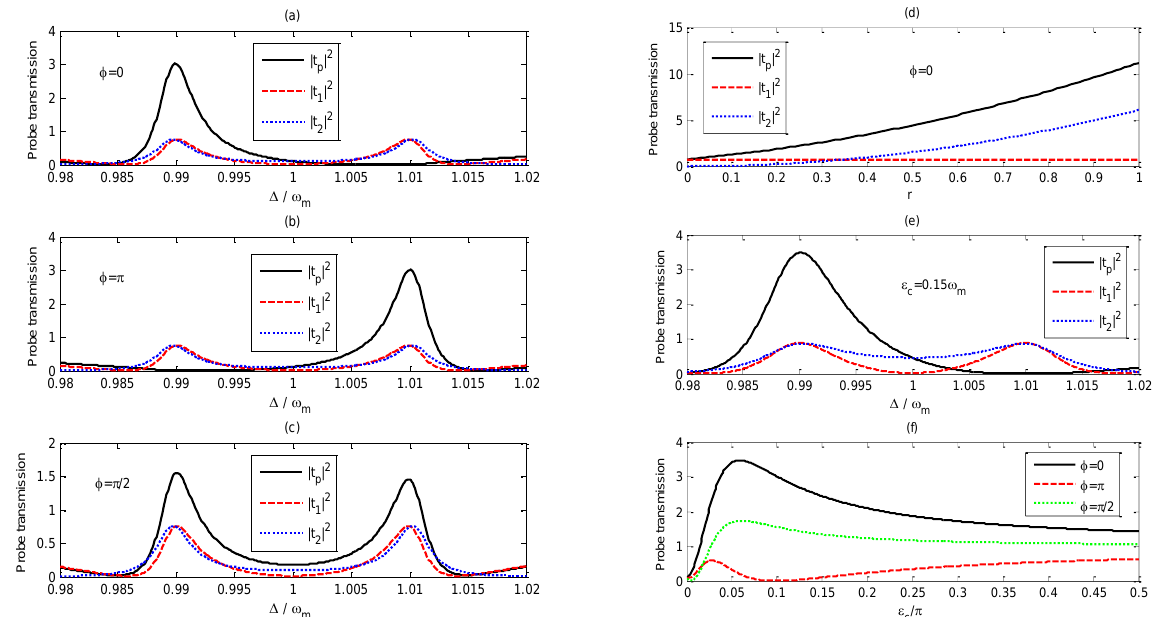
Figure 3. Curves of |𝑡 𝑝 | 2 , |𝑡 1 | 2 , |𝑡 2 | 2 vary with the probe-pump field detuning 𝛥 𝜔 𝑚 ⁄ when 𝜙 equals to ( a ) 0, ( b ) 𝜋 and ( c ) 𝜋 2⁄ , respectively. ( d ) Curves of |𝑡 𝑝 | 2 , |𝑡 1 | 2 , |𝑡 2 | 2 at ∆ = 𝜔 𝑚 − 𝐽 vary with 𝑟 = 𝜇𝜀 𝑞 𝜀 𝑝 ⁄ when the phase difference 𝜙 = 0 . ( e ) Curves of |𝑡 𝑝 | 2 , |𝑡 1 | 2 , |𝑡 2 | 2 vary with the probe-pump field detuning 𝛥 𝜔 𝑚 ⁄ for 𝜙 = 0 when the pump field am- plitude 𝜀 c equals to 0.15𝜔 𝑚 and 𝑟 = 0.52 . ( f ) Curves of |𝑡 𝑝 | 2 at ∆ = 𝜔 𝑚 − 𝐽 vary with pump field amplitude 𝜀 𝑐 2𝜋⁄ for different phase difference ϕ when r =0.35. The other parameters are the same as those in Figure 2.